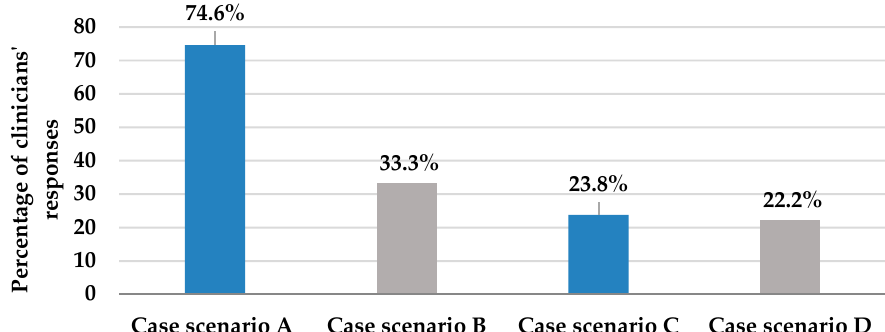
Figure 1. This figure describes clinicians’ responses to question 1; selection of the appropriate case scenario where immediate empiric antifungal should be started, from 4 provided patient case scenarios. Case scenario A: Patient is still febrile and did not respond to broad-spectrum antibiotics (appropriate). Case scenario B: Patient shows a positive B-D-glucan test (inappropriate). Case scenario C: Patient exhibits signs of septic shock and is on maintenance hemodialysis (appropriate). Case scenario D: Patient is vitally stable, but urine culture reveals Candida species growth (inappro-